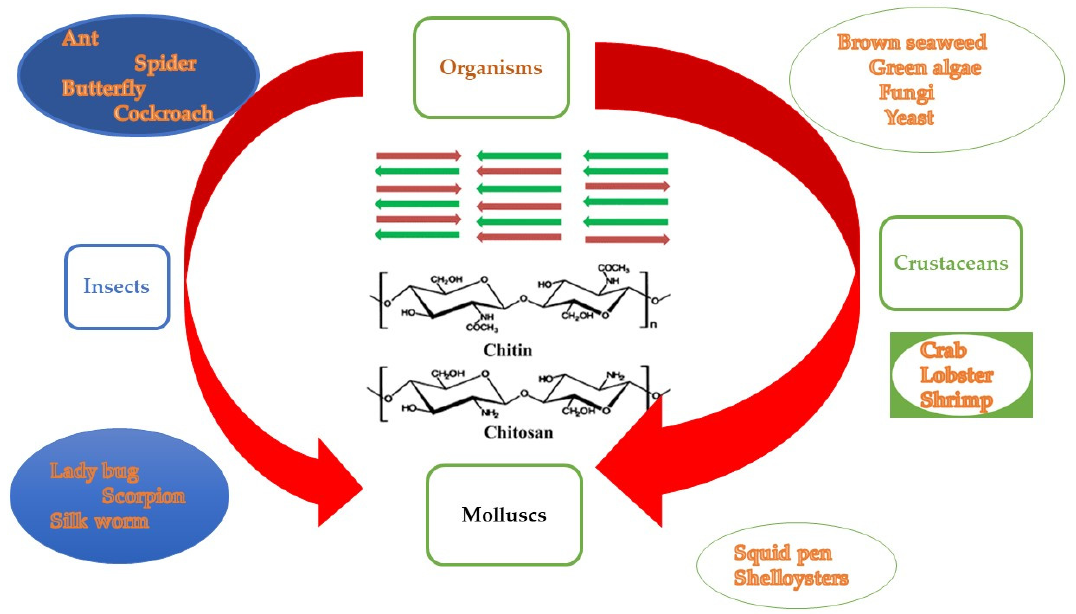
Figure 5. Sources of chitin/chitosan.